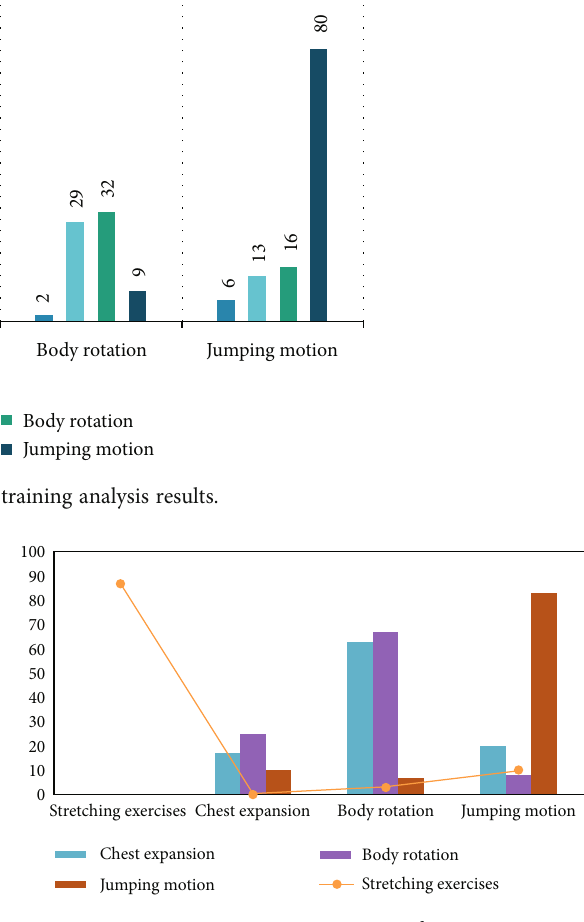
9: Nonstationary K -means confusion